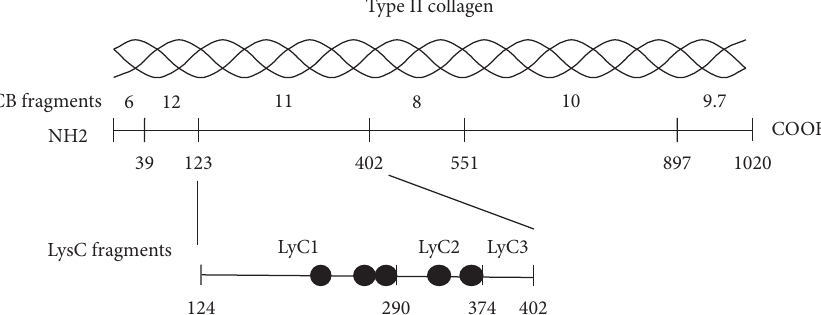
Figure 2: Localization of arthritogenic epitopes on cyanogen bromide (CB) digested type II collagen fragments (CB 6, 8, 9.7, 10, 11, and 12). The circles represent the epitopes of the arthritogenic monoclonal antibodies on endoproteinase (LysC)-digested CB11 fragments (LysC1, LysC2, and LysC3).